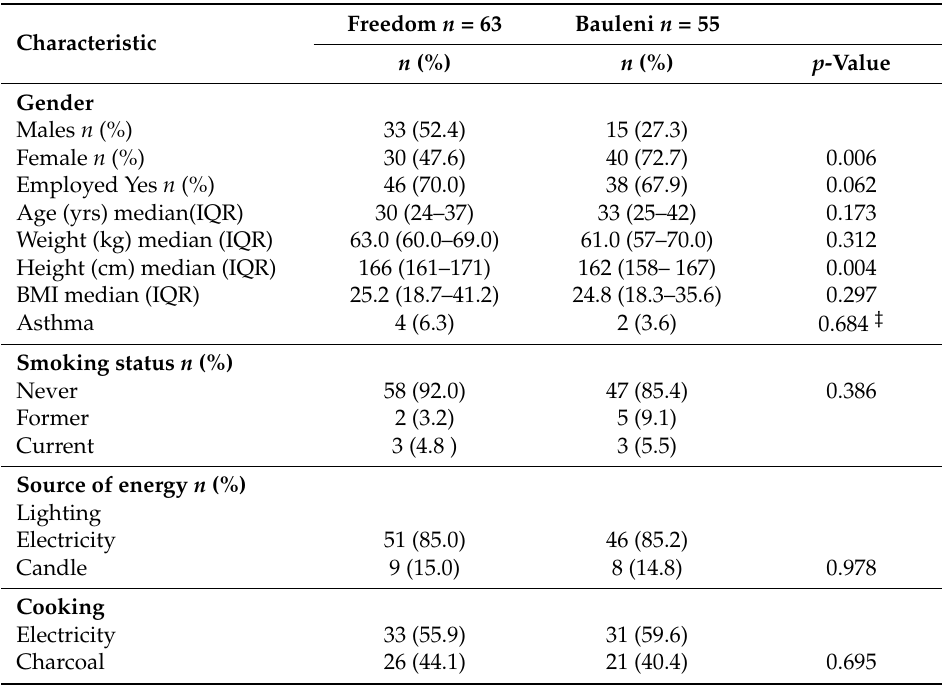
Table 1. Baseline characteristics study